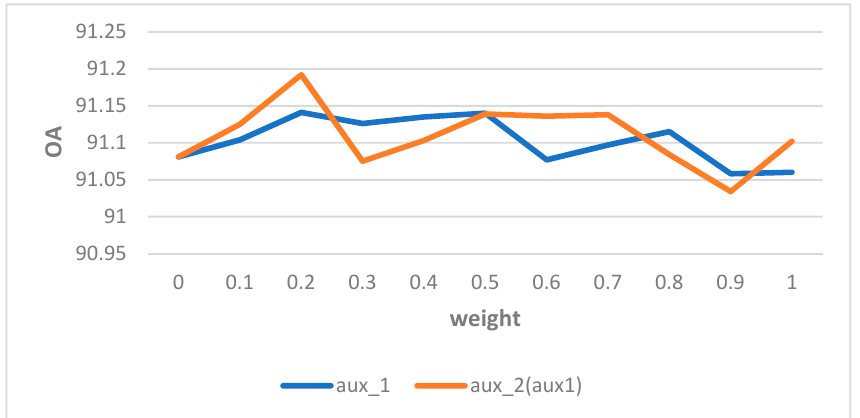
Figure 4. Comparison of different weight parameters. It is important to note that the experiment with AUX2 was based on the optimal weighting of AUX1 that had been selected.